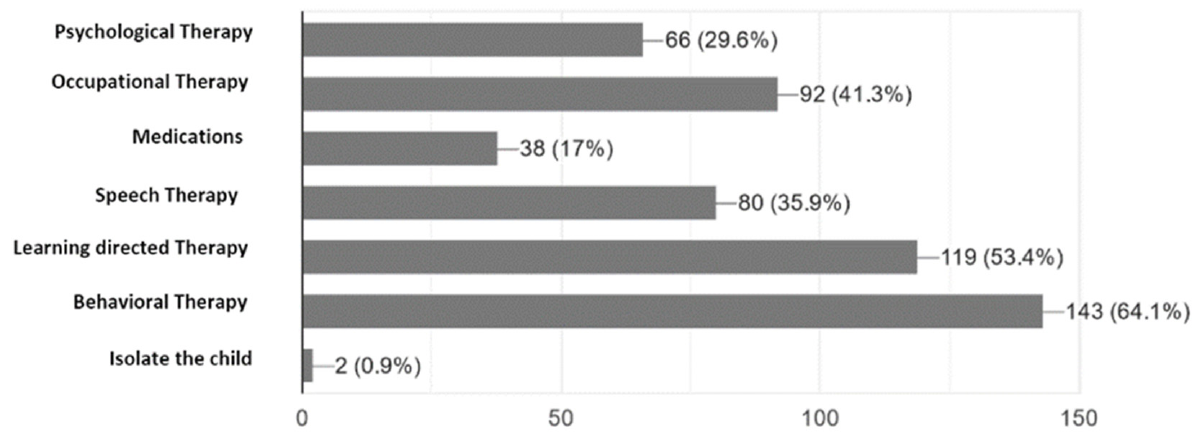
Figure 2. Caregivers subjective point of view on the most effective intervention for their children.